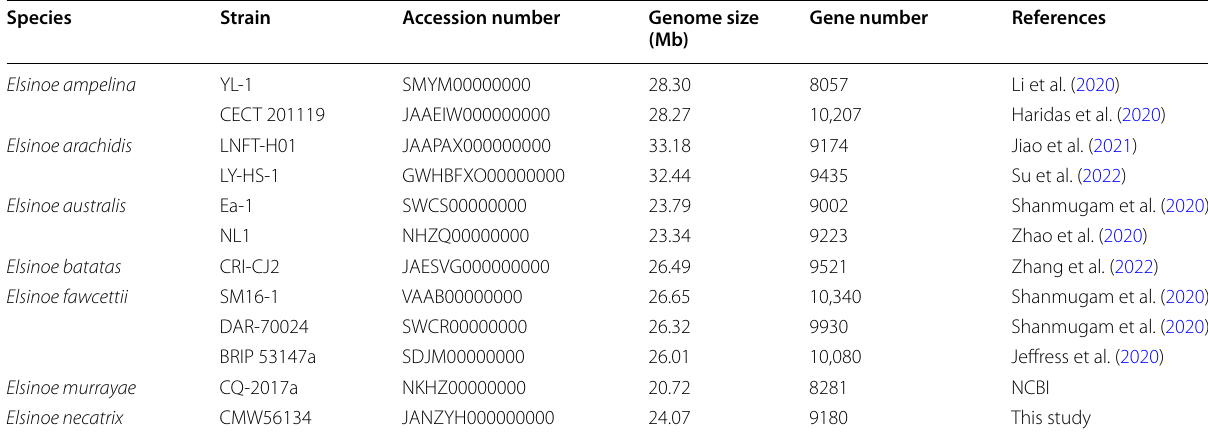
Table 1 Genome assembly features of Elsinoe